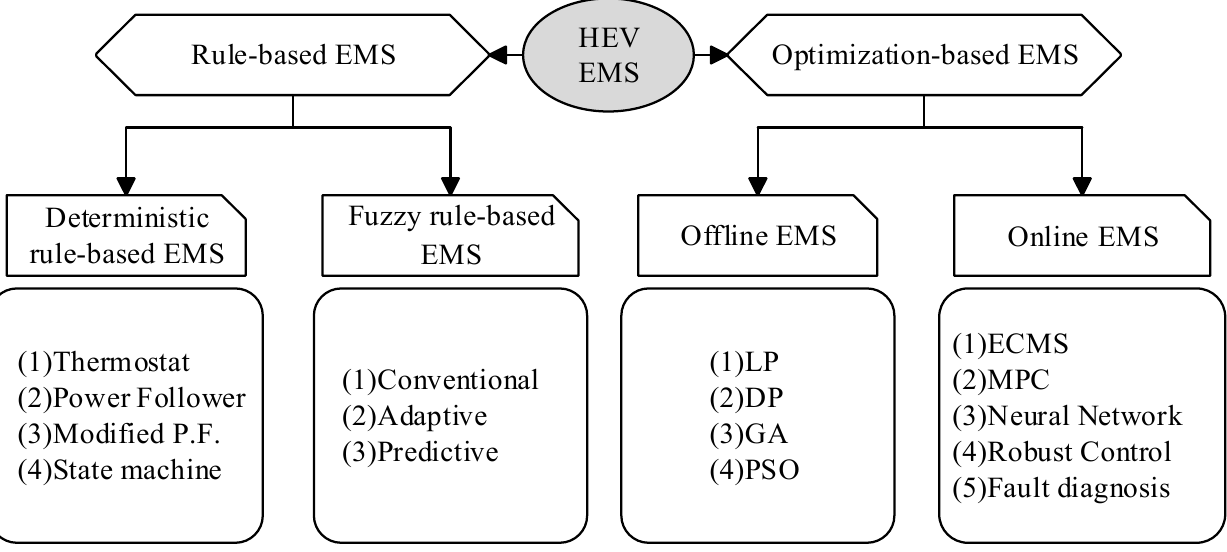
Figure 2. Classi fi cation of EMS for HEV. Figure 2. Classification of EMS for